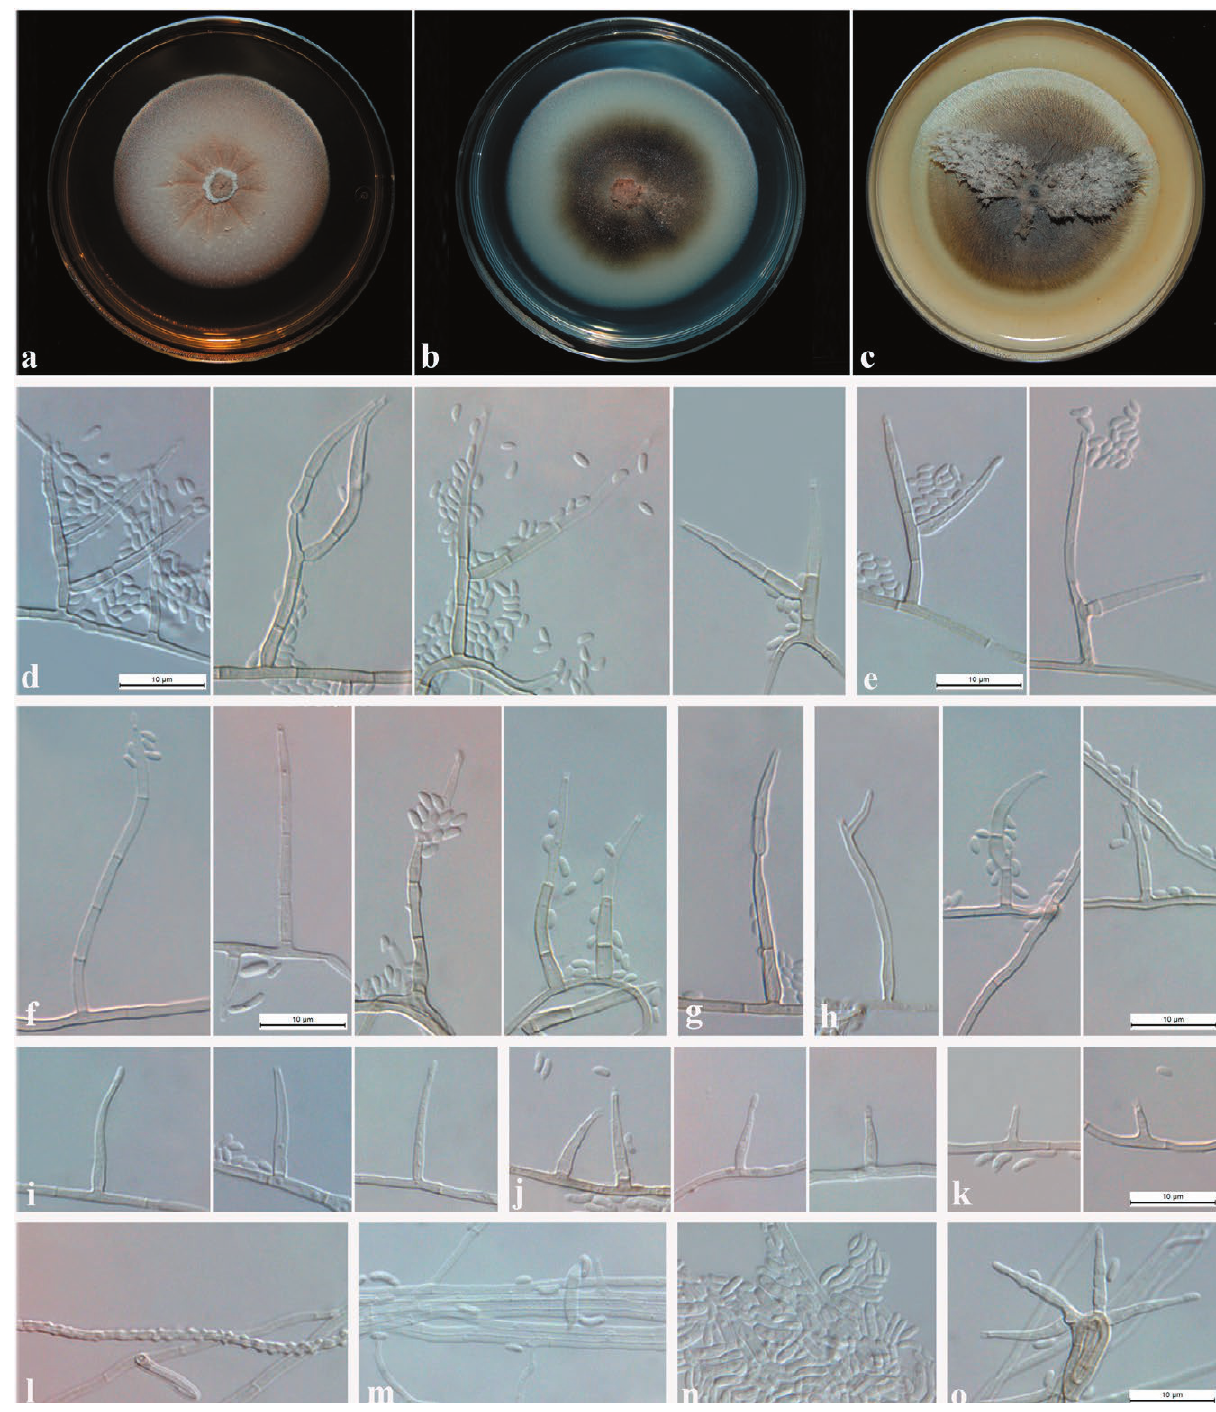
Figure 5. Representative light micrographs (Nomarski differential interference contrast) of Phaeoacremonium alvesii CBS 113590 as the rep- resentative strain of sub-group #7. Twenty-one-day-old colonies grown on malt extract agar ( a ), potato dextrose agar ( b ) and oatmeal agar ( c ) at 23±2°C; ( d ) branched conidiophores; ( e ) unbranched conidiophores with lateral phialides; ( f ) unbranched septate conidiophores; ( g ) conidiophores with percurrent rejuvenation; ( h ) polyphialides; ( i ) Type III phialides; ( j ) Type II phialides; ( k ) Type I phialides; ( l ) hyphae with prominent exudate droplets observed as warts; ( m ) hyphae occurring in bundles; ( n ) conidia; ( o ) hyphal